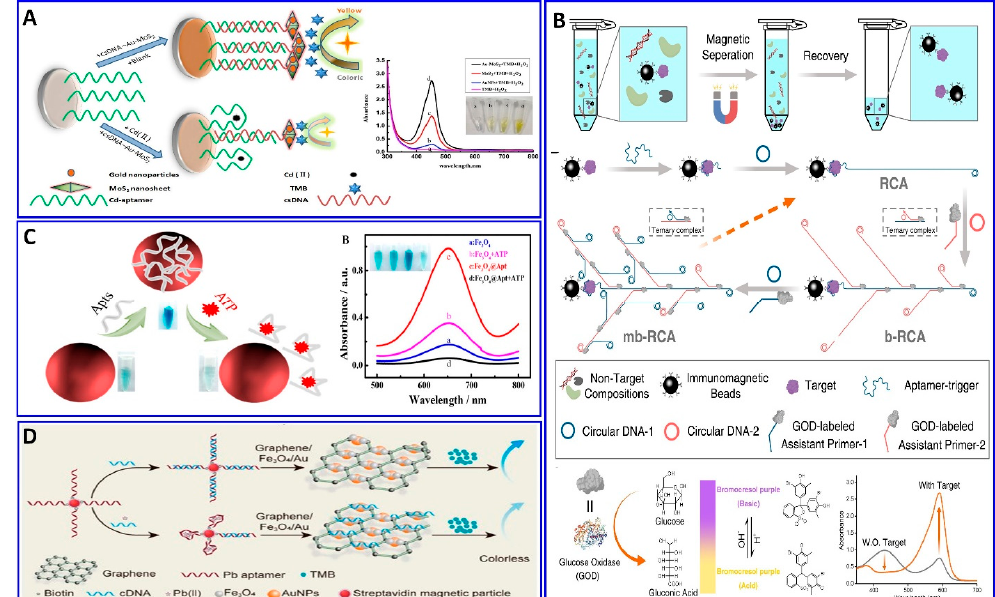
Figure 4. ( A ) Principal strategy for Cd 2+ assay via the enhanced peroxidase-like activity of Au–MoS 2 -based aptamer, reproduced from [101]. ( B ) Principal protocol for the PDGF-BB assay via a glucose oxidase enzyme, inducing changes in pH-equipped immunomagnetic beads and mb-RCA as a signal amplifier, reproduced from [103]. ( C ) Schematic diagram showing the procedure and mechanism of the ATP assay via colorimetric aptamer technology based on the peroxidase-like catalysis properties of Fe 3 O 4 , reproduced from [106]. ( D ) Colorimetric procedure for Pb 2+ assay based on the peroxidase-mimicking activity of graphene/Fe 3 O 4 -AuNPs aptamer technology, reproduced from [107]. Replacing the antibodies with aptamers in the ELISA protocol has attracted attention for assaying food-borne pathogens (e.g., E. coli ), as reported by Duan et al.’s group [108]. First, the biotin aptamer was immobilized on the surface of an avidin-coated microplate